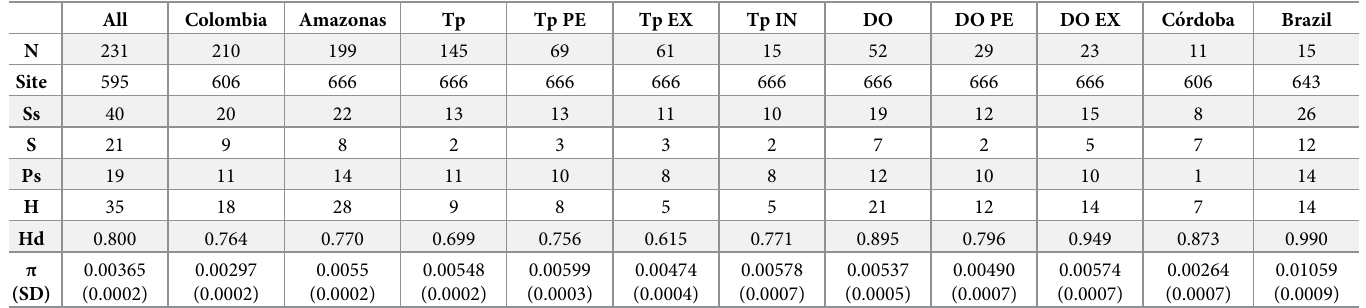
The available sequences were used for genetic diversity estimators. n: the amount of sequences analyzed, Site: the total of sites analyzed, excluding gaps. Ss: the total of segregating sites, S: the total of singleton sites, Ps: the total of parsimonious sites, H: the number of haplotypes, π : nucleotide diversity by site, SD: standard deviation, Hd: haplotype diversity. Abbreviations: Tipisca (Tp); Tipisca peridomiciliary (Tp PE); Tipisca extradomiciliary (Tp EX); Tipisca intradomiciliary (Tp IN); Doce